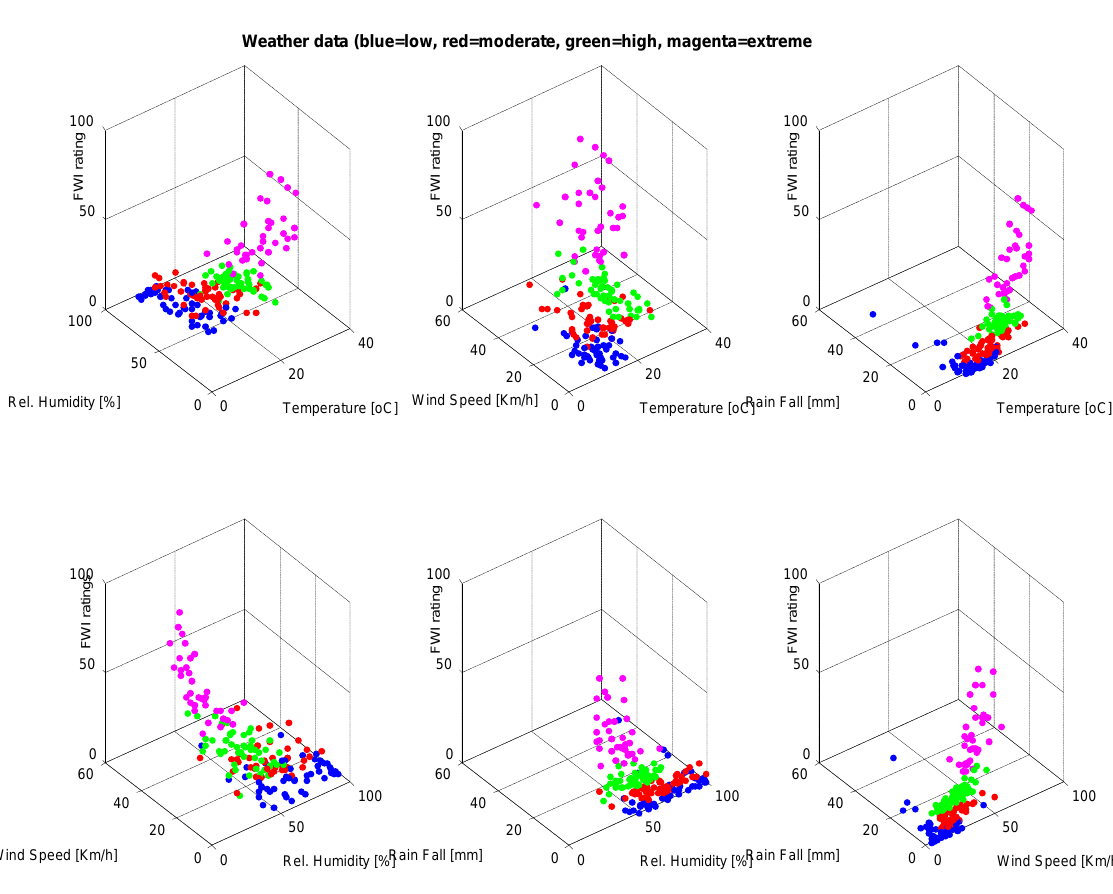
Figure 3. 3D classification of the weather